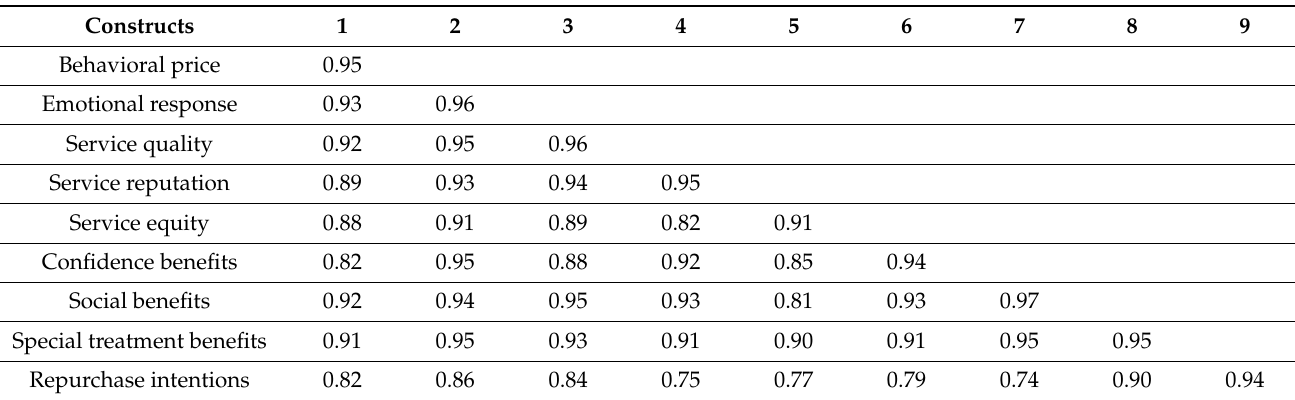
Table 3. Discriminant